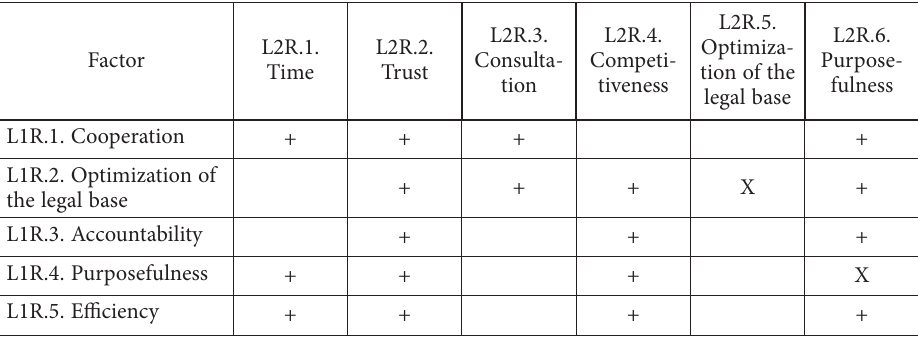
Table 1. Regulation process factors (created by the authors)